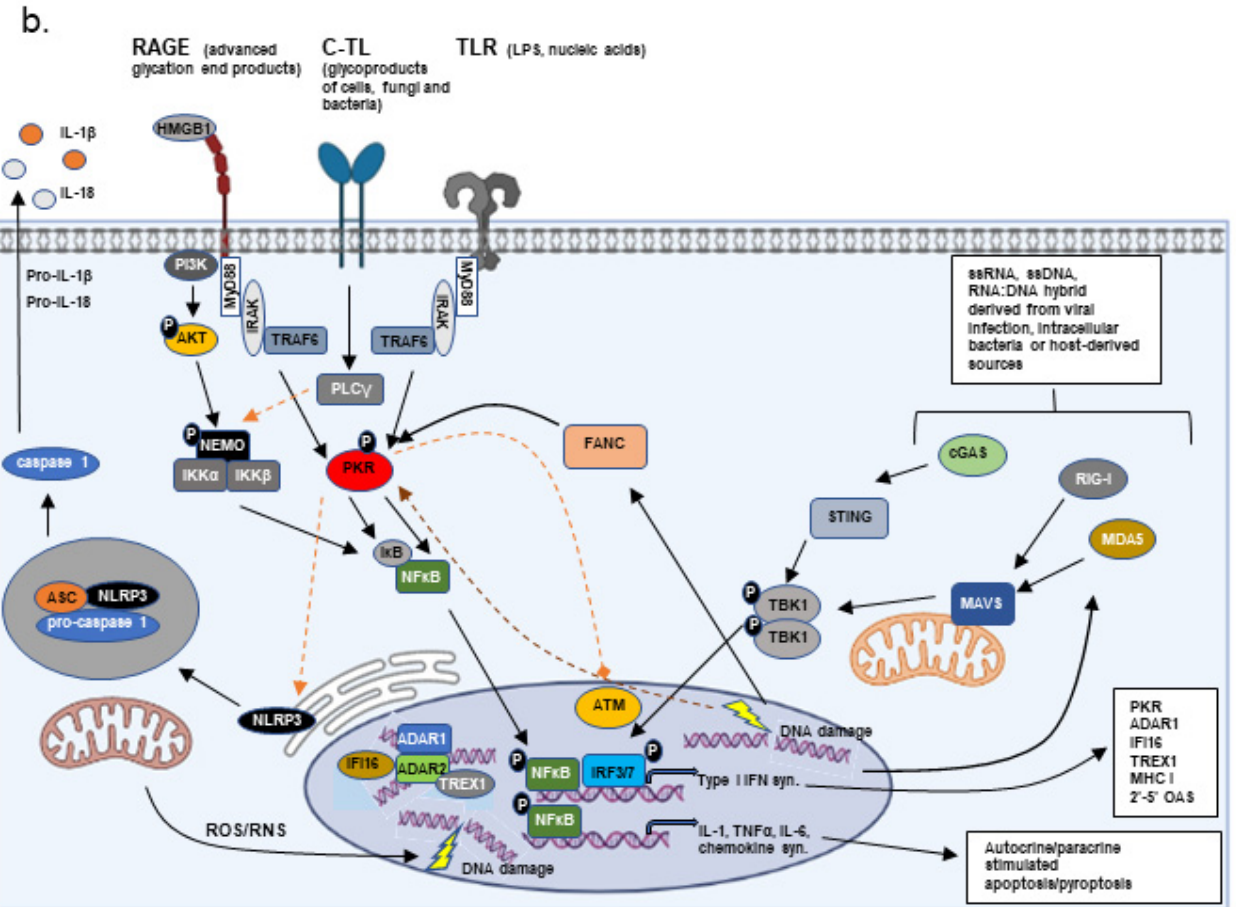
Figure 1. Innate Immune Signaling. The major signal transduction pathways mediated by extracellu- lar and intracellular Pattern Recognition Receptors (PRRs) of both Pathogen-Associated Molecular Patterns (PAMPs) and Damage-Associated Molecular Patterns (DAMPs) are presented. ( a ) Extra- cellular pathogens, stressors, and products from damaged cells can result in the stimulation of the receptor for advanced glycation end products (RAGE; high mobility group box (HMGB)-1, advanced glycation end products (AGE)), C-type lectin (C-TL; glycoproducts of bacteria, fungi) or Toll-like receptors (TLR; nucleic acids, LPS, glycoproteins), primarily resulting in the activation of nuclear factor- κ B (NF- κ B) through signaling mediated by AKT and/or PKR. AKT stimulates survival, while PKR phosphorylates eukaryotic initiation factor 2 α (eIF2 α ) and p53, inhibiting general translation and promoting p53 stability, respectively. Additionally, PKR results in both the phosphorylation and degradation of inhibitor κ B (I κ B) and the phosphorylation of p65 NF- κ B, promoting the translo- cation of p65 NF- κ B to the nucleus and the stimulation of NF κ B-dependent transcripts, including cytotoxic cytokines and type I interferon. Activation of the intracellualar PRRs (RIG-I, MDA5, or cGAS) promote the phosphorylation and activation of interferon response factors (IRF)-3 and -7. In conjunction with p65 NF- κ B, IRF3/7 stimulates the synthesis of type I interferon, which is secreted, thereby having both paracrine and autocrine effects. The associated signaling can promote cell death as well as the recruitment of immune cells to the site of damage/stress. AKT-mediated suppression of GSK3 promotes β -catenin ( β -cat) translocation to the nucleus and the synthesis of IRF3. In many autoinflammatory/degenerative diseases, GSK3 remains active and interferon signaling is defective. ( b ) Under chronic stress conditions (environmental factors, DNA repair defects (FANC)), prolonged activation of the PRRs and interferon-inducible kinase PKR leads to phosphorylation and inactivation of the DNA repair kinase, ATM, and an enhancement in the rate of mutagenesis. In addition, a number of interferon-inducible proteins, which act as both epigenetic modifiers and DNA repair proteins, associate with sites of DNA strand breaks, potentially regulating the mutation incorporation